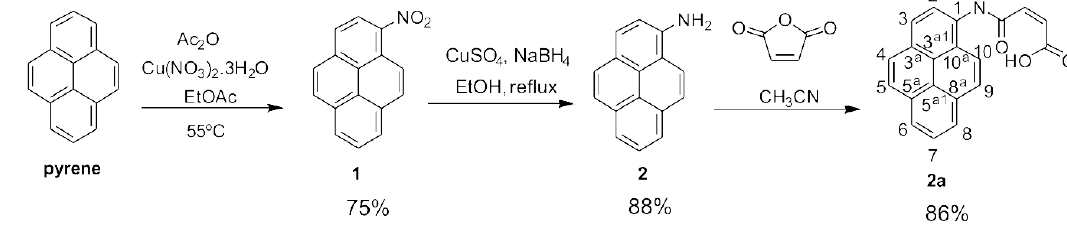
Figure 1. Schematic representation of the pyrene derivative synthesis.